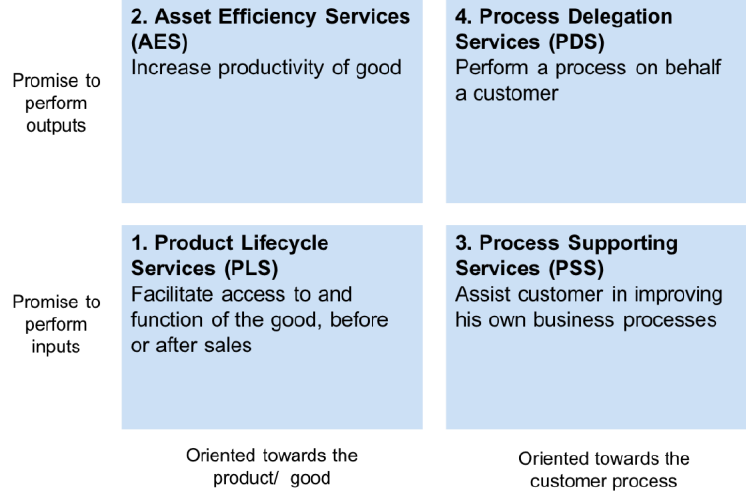
Fig. 1. Input- vs. output-based services (adapted from